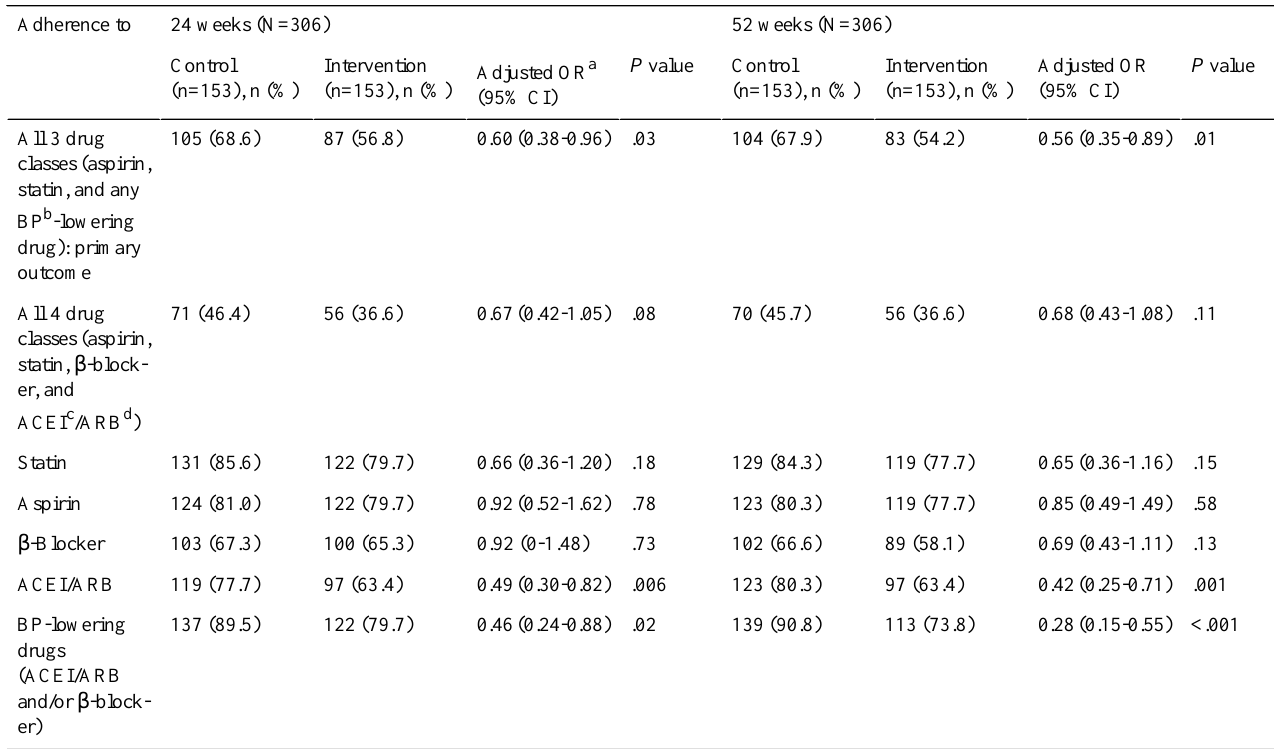
Table 2. The effect of intervention on medication adherence at 24- and 52-week follow-up (full cohort).